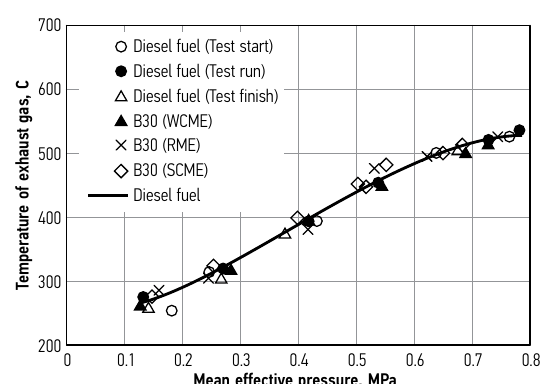
Fig. 6. The dependence of the charge air pressure P K of 1Z diesel engine on mean effective pressure P me